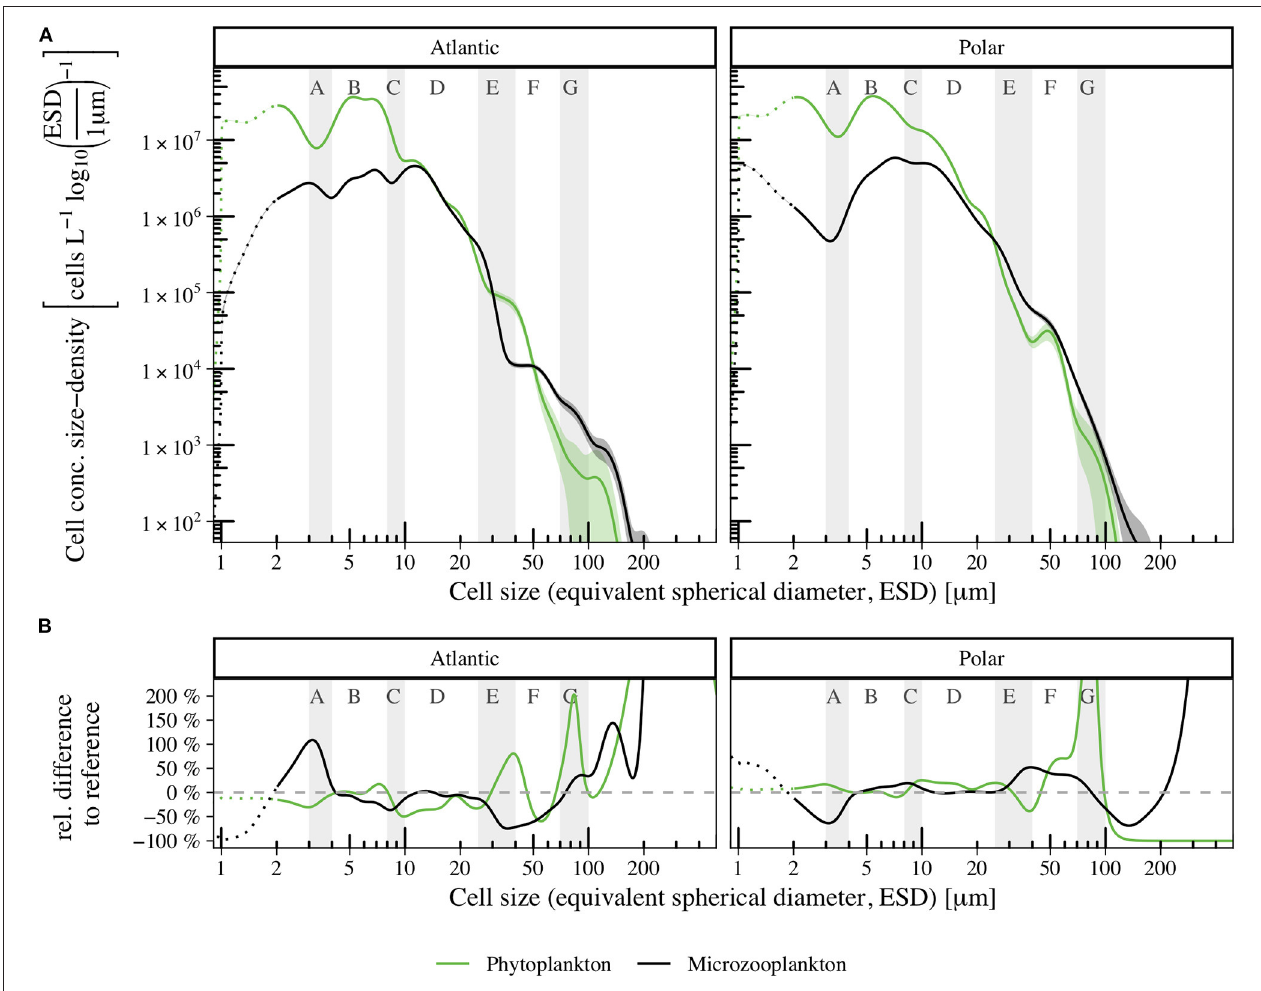
FIGURE 4 | Size spectra for autotrophic phyto- (green) and heterotrophic microzooplankton (black) in samples from the Atlantic (left) and Polar (right) section of the study site (A) . Shaded areas indicate the confidence interval (95% CI), dotted lines indicate reduced reliability of size measurements for cells with ESD < 2 µ m. Relative differences between the Polar and Atlantic size spectra to the reference (combined spectrum of all samples, see Supplementary Material ) in percent (B)